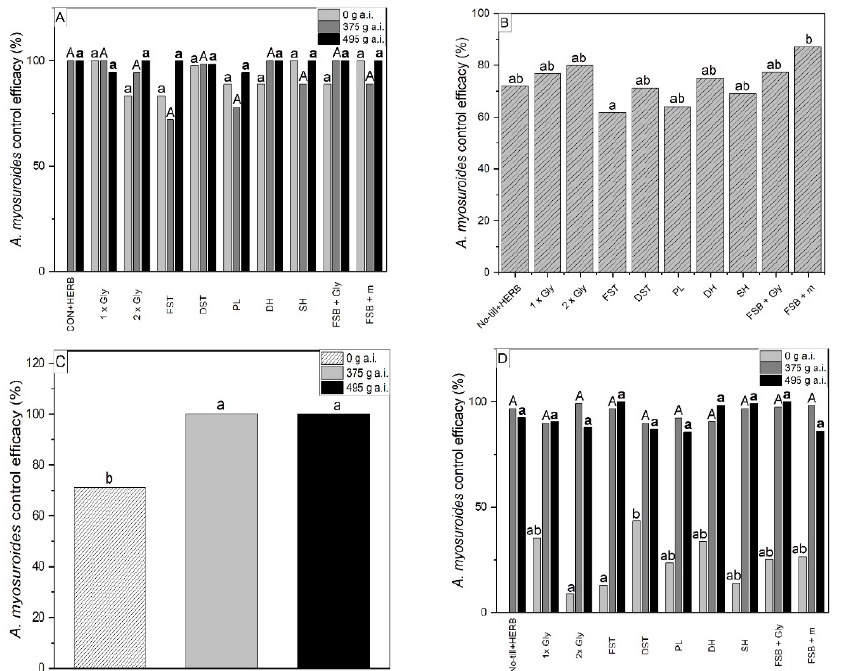
Figure 2. A. myosuroides control efficacy recorded at ( A ) B. Kreuz 56 DAS, ( B ) B. Kreuz 120 DAS, ( C ) Sieben Jauchert 56 DAS and ( D ) Risp 120 DAS from 2019 to 2020. The application rate of cinmethylin is included in the upper right corner. Means with different letters show significant differences between the treatments according to Tukey’s HSD test at α ≤ 0.05. No -till + HERB = No soil tillage with chemical weed management, 1x Gly = 1x glyphosate application, 2x Gly = 2x glyphosate application, FST = Flat soil tillage, DST = deep soil tillage, PL = ploughing, DH = disc harrow, SH = straw harrow, FSB + Gly = false seedbed + glyphosate, FSB + m = false seedbed + rotary hoe.